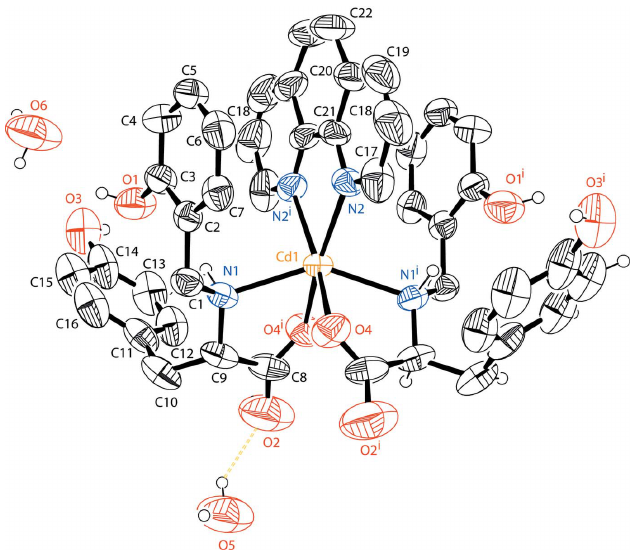
Figure 1 The molecular structure of the title compound, showing the atom labelling for the asymmetric unit. Displacement ellipsoids are drawn at the 50% probability level. The unabelled atoms are related to the labelled atoms by symmetry operation y , x , (cid:5)